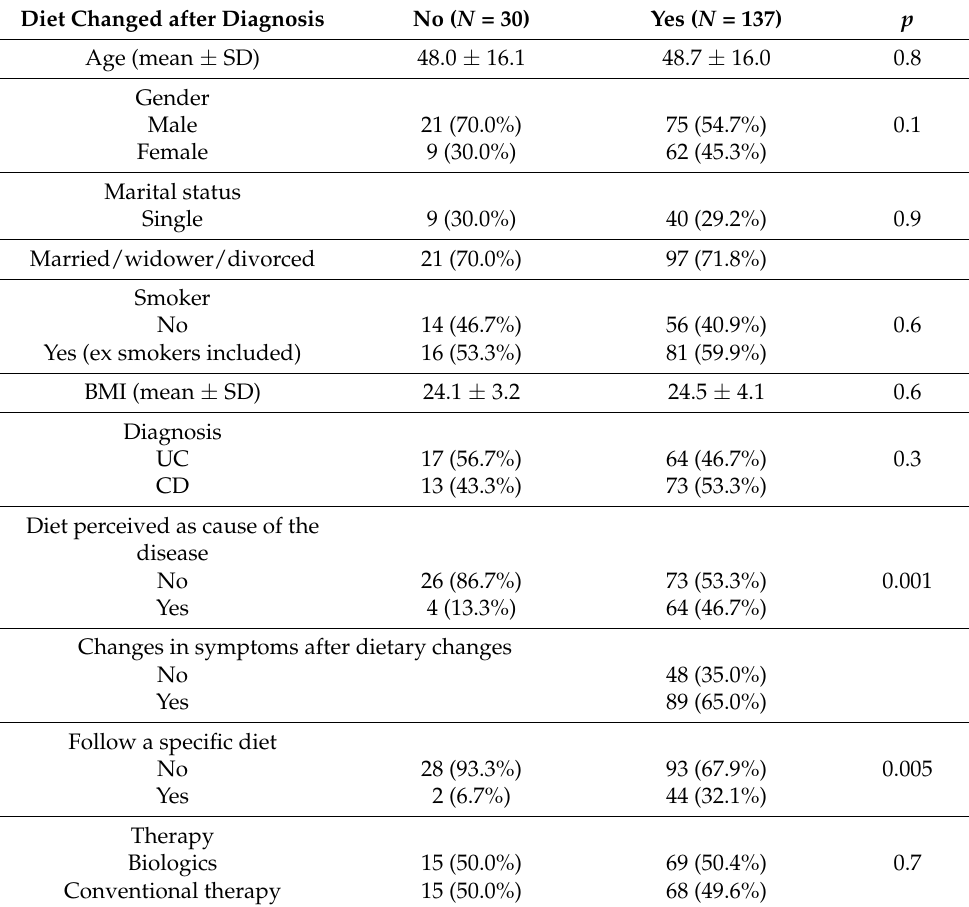
Table 4. Comparison between patients who modified their diet and those who did not. Diet Changed after